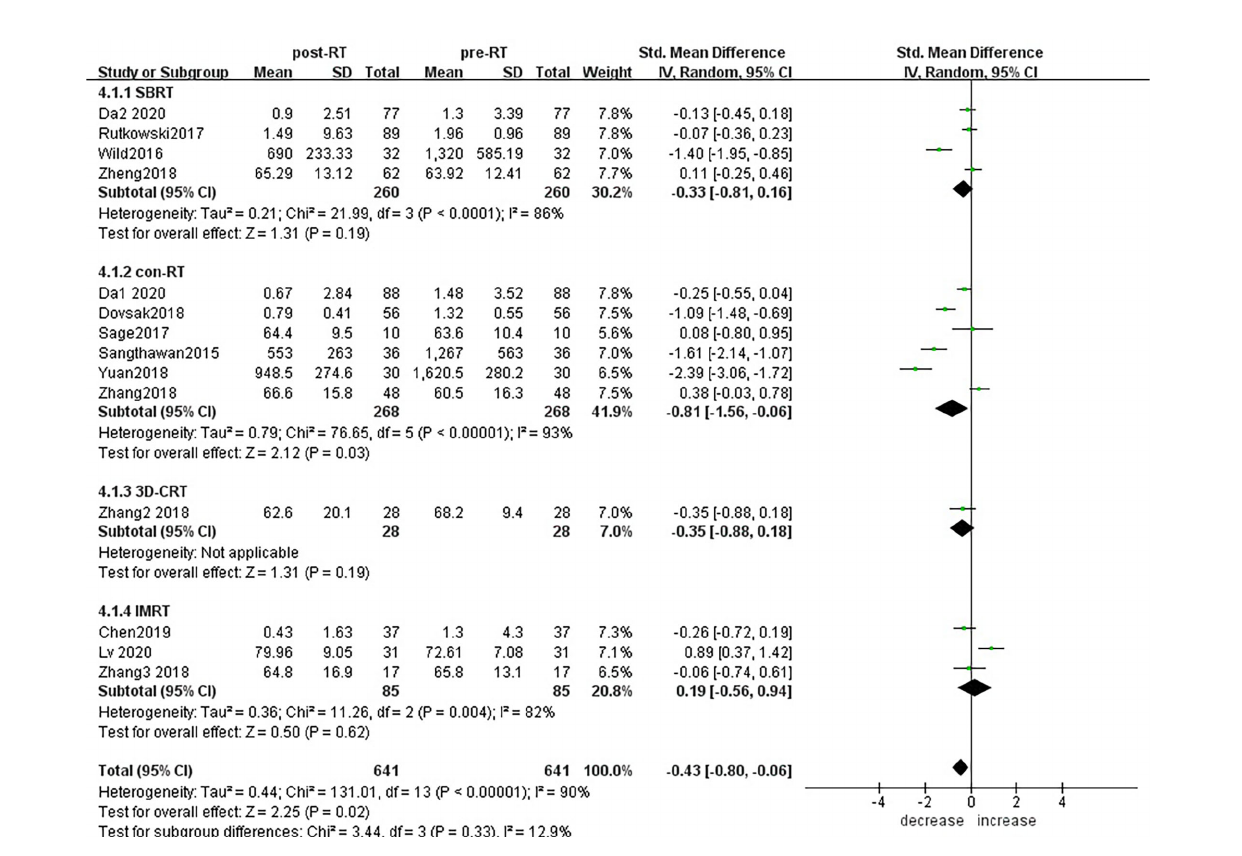
FIGURE 6 | Forest plots of subgroup analysis for changes of CD3+ T lymphocyte after radiotherapy compared with before radiotherapy with different radiotherapy technology. con-RT, stereotactic body radiotherapy; SBRT, stereotactic radiotherapy; IMRT, intensity-modulated radiotherapy; 3D-CRT, three-dimensional conformal